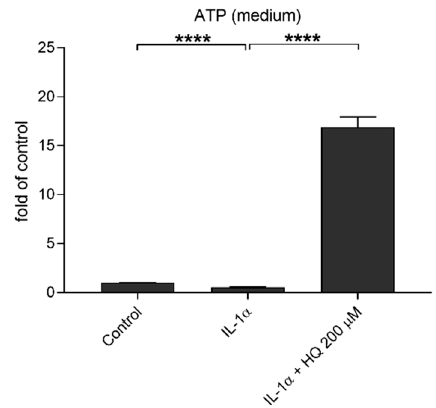
Figure 9. The effect of hydroquinone (HQ 200 μ M; 18 h) exposure on the levels of extracellular ATP in IL-1 α -primed ARPE-19 cell cultures. Results were normalized to the untreated control group. Data were combined from three independent experiments with four parallel samples per group in each experiment. Results are shown as mean ± SEM. **** P < 0.0001, Mann-Whitney U-test. [Kruskal-Wallis test, *** P < 0.001].